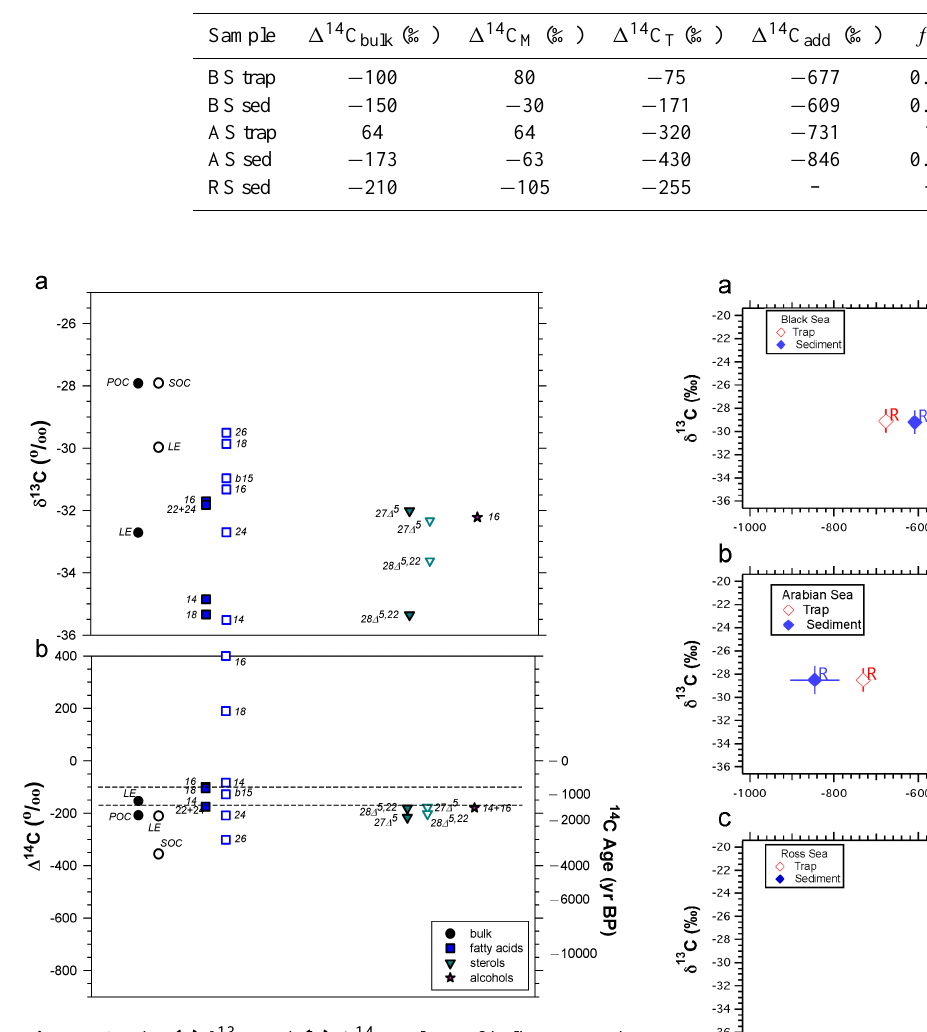
Table 5. Isotopic values used in mass balance calculations. The values of f M , f T and f R are those values calculated assuming that the actual value of (cid:49) 14 C added is that measured on the compounds defined as relict.